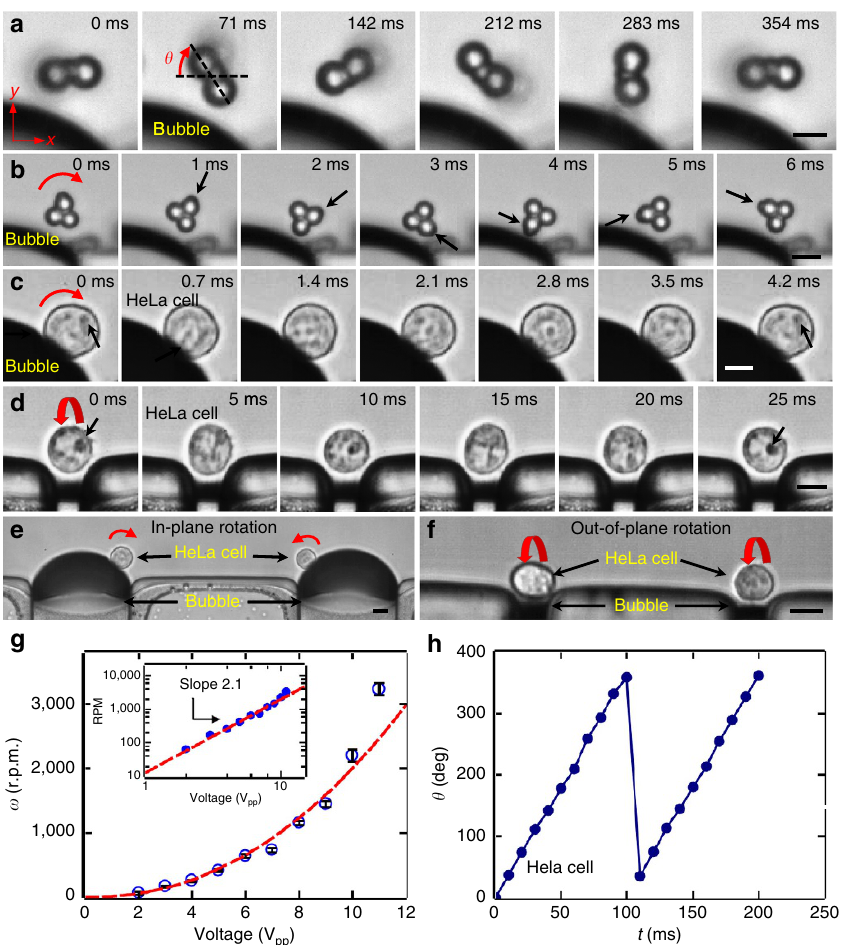
Figure 4 | High-speed imaging showing the rotational motion of microparticles and cells caused by an oscillating microbubble. Clockwise and in-plane rotation motion of ( a ) a doublet and ( b ) a triplet. ( c ) Counter clockwise in-plane rotation of a HeLa cell. ( d ) Out-of-plane rotation of a HeLa cell. Parallel ( e ) in-plane and ( f ) out-of-plane rotation of a HeLa cells. ( g ) Plot of rotational speed o against driving voltage V PP of a HeLa cell driven by an oscillating microbubble, with a constant excitation frequency. The rotational rate of the cell varies as the second power of the driving voltage, o p V 2.1 . ( h ) Plot of the rotational angle y versus a function of time t for a HeLa cell. Error bars represent standard deviation ( n Z 5). Scale bars, 10 m